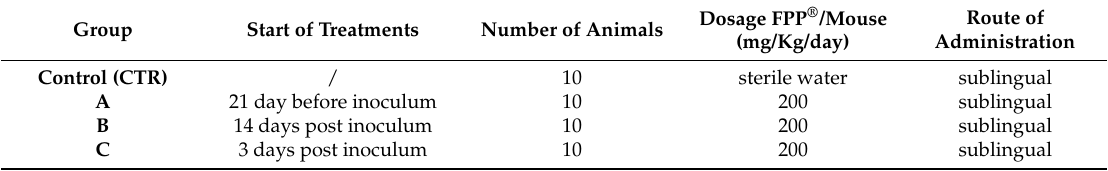
Table 3. Experimental scheme of fourth experiment in C57/Bl mice treated with FPP ®